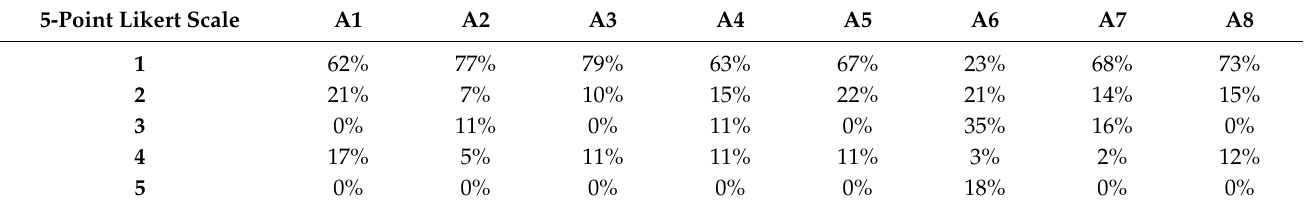
Table 4. Summary of the results of the usability evaluation.